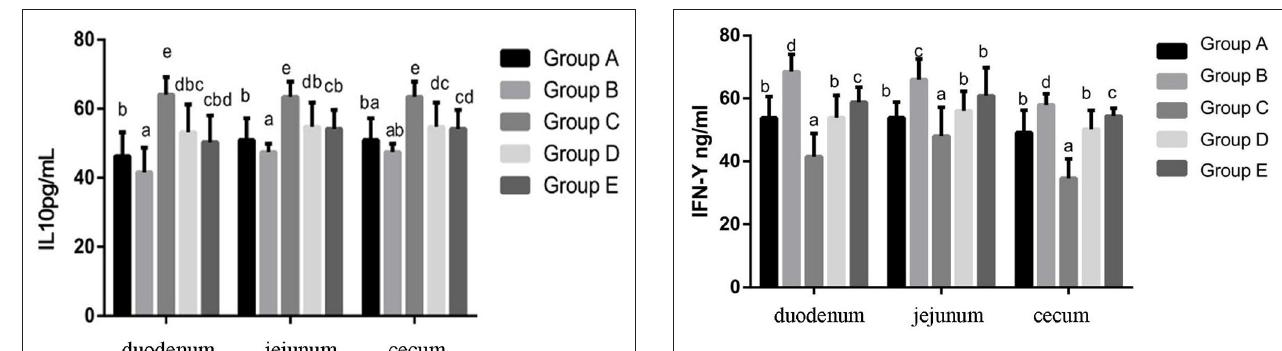
higher than that of the antibiotic group. It indicated that